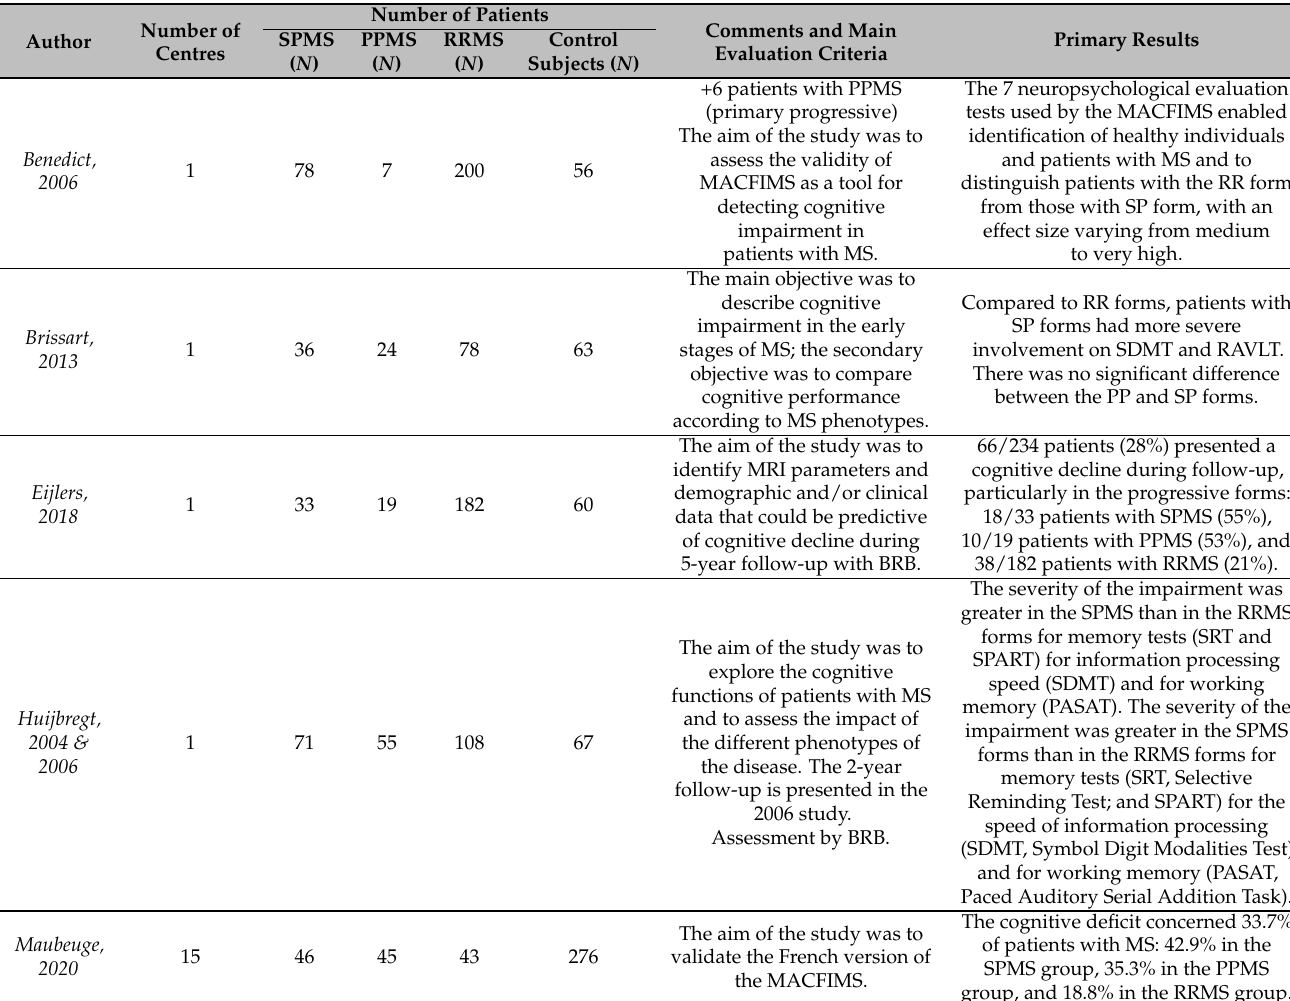
Figure 1. Flow chart of included studies. Table 1. Controlled studies about cognition in secondary progressive multiple sclerosis.